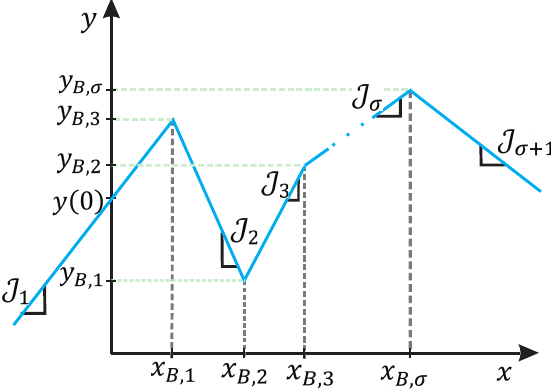
Figure 6. Single-valued piecewise linear